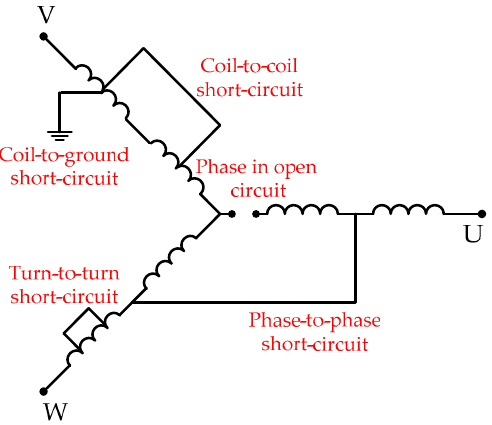
Figure 1. Possible failure modes that can affect the stator windings [10].